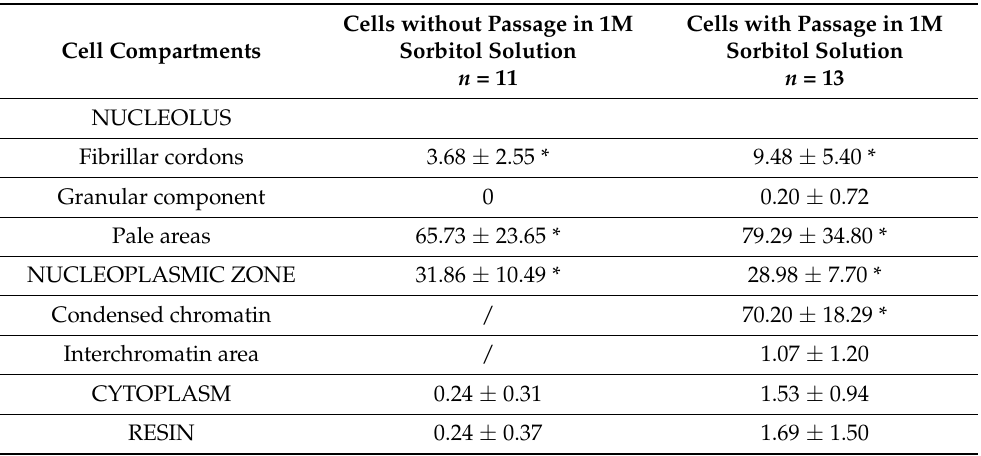
Table 2. Mean density of the label (number of gold particles per square micrometre) obtained in different compartments of yeast cells with or without passage in 1M sorbitol solution, as revealed after the application of the immunocytological technique using TdT as well as the standard